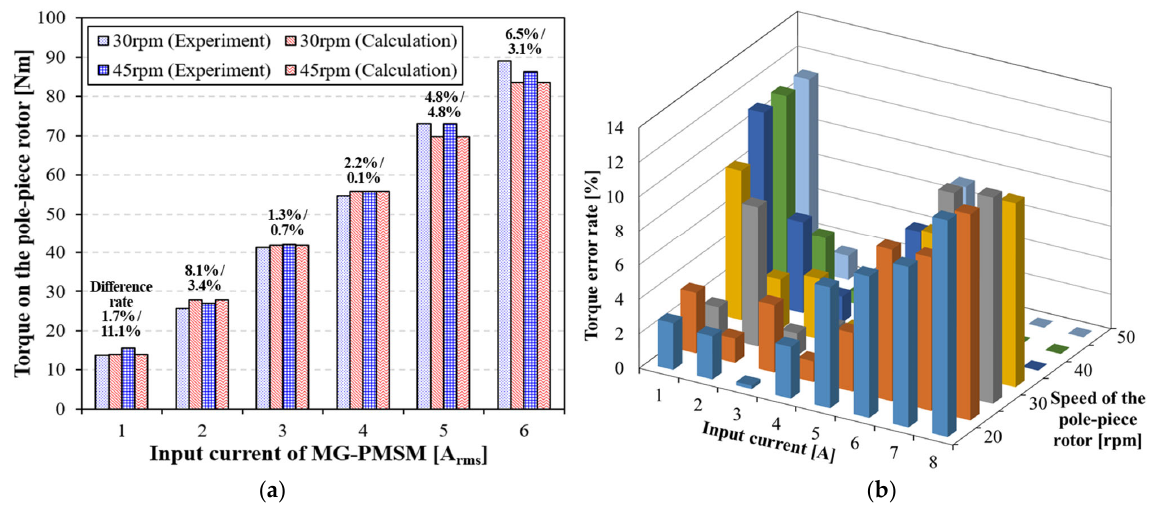
Figure 18. Comparison of the experimental and calculated values of the torque generated in the pole piece rotor by the load performance test of 4.5kW ‐ class MG ‐ PMSM prototype: ( a ) Rotational speed of the pole piece rotor: 30 and 45 rpm; ( b ) Torque error rate distribution between experimental and calculated values in the low speed ‐ torque region.